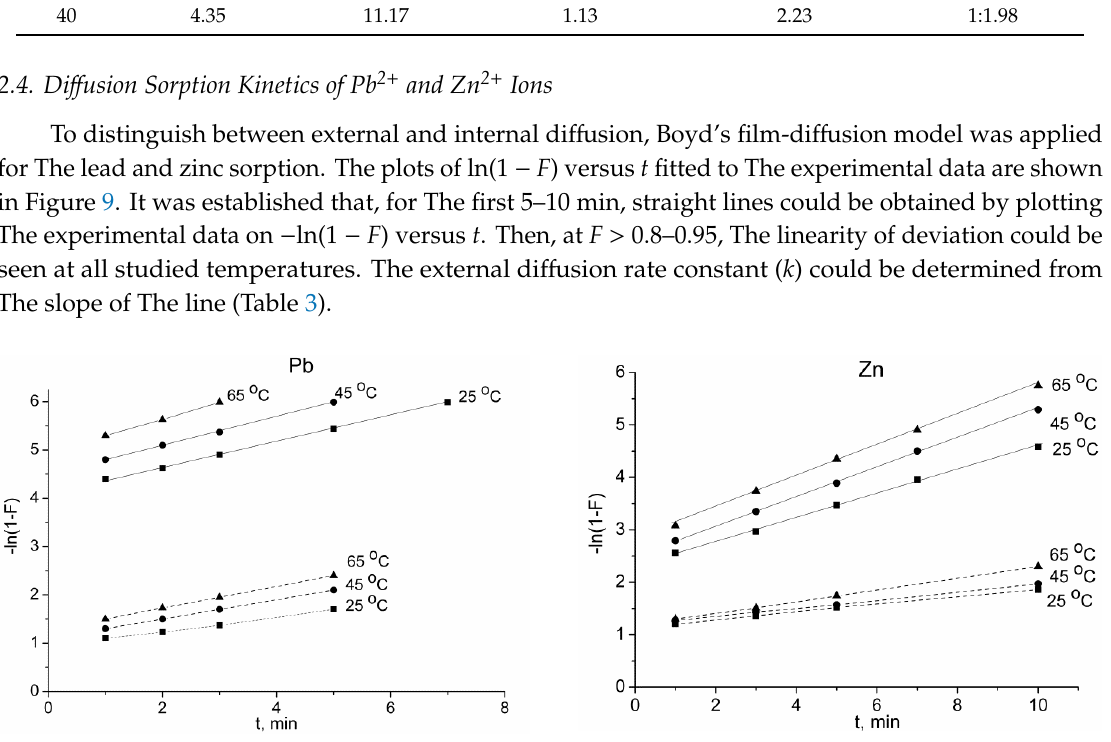
Table 3. Kinetic parameters of the film diffusion model for Pb 2+ and Zn 2+ sorption at different temperatures and solute concentrations on titanium phosphate.